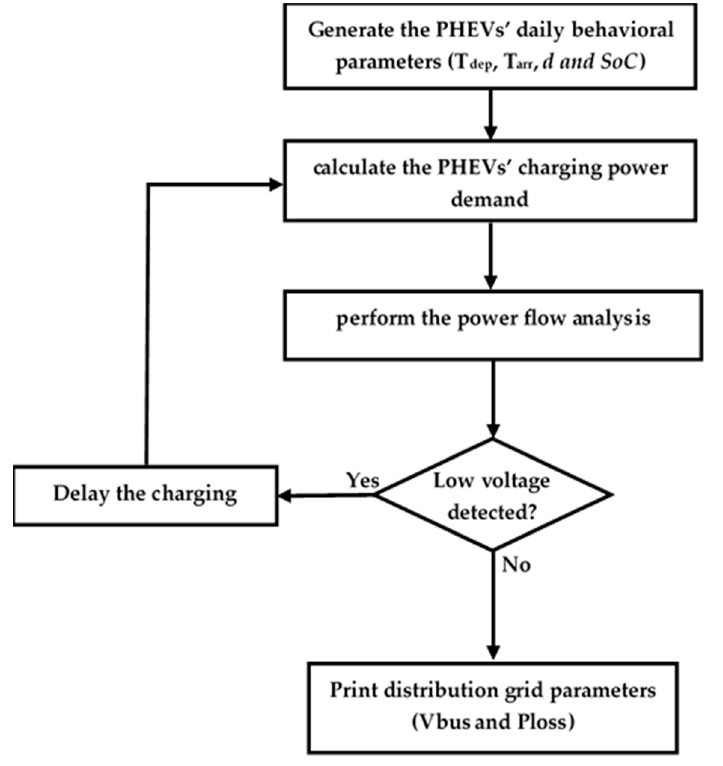
Figure 8. Controlled charging for the PHEV fleet.